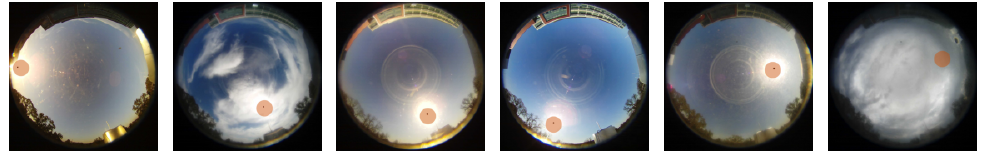
Figure 7. The SunMask, in orange colour for visualization purposes, for a few selected image